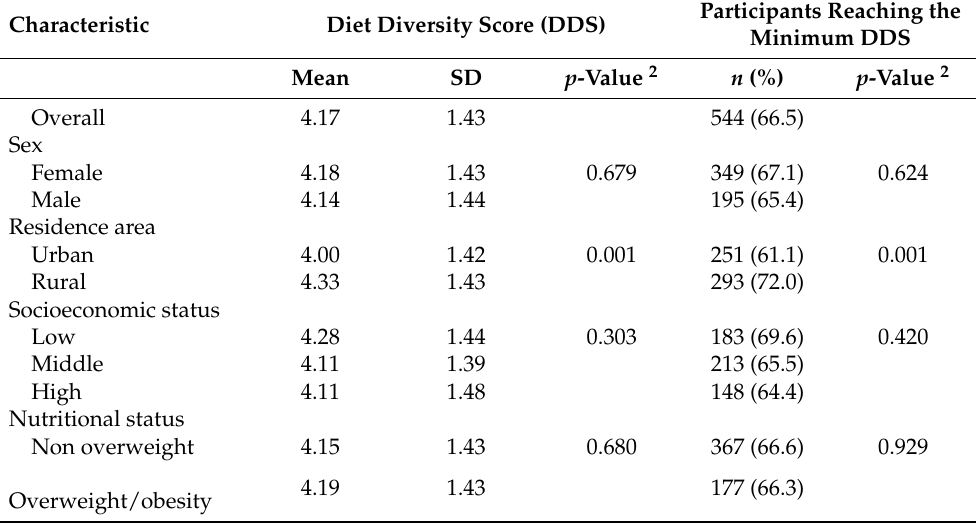
Table 2. Diet Diversity Score (DDS) and proportion of participants reaching the minimum DDS 1 ( n =